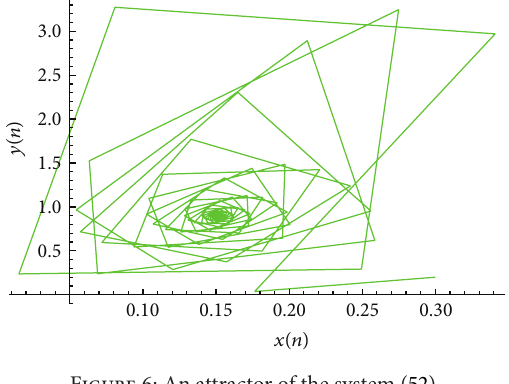
Figure 8: Plot of 𝑦 𝑛 for the system (53).